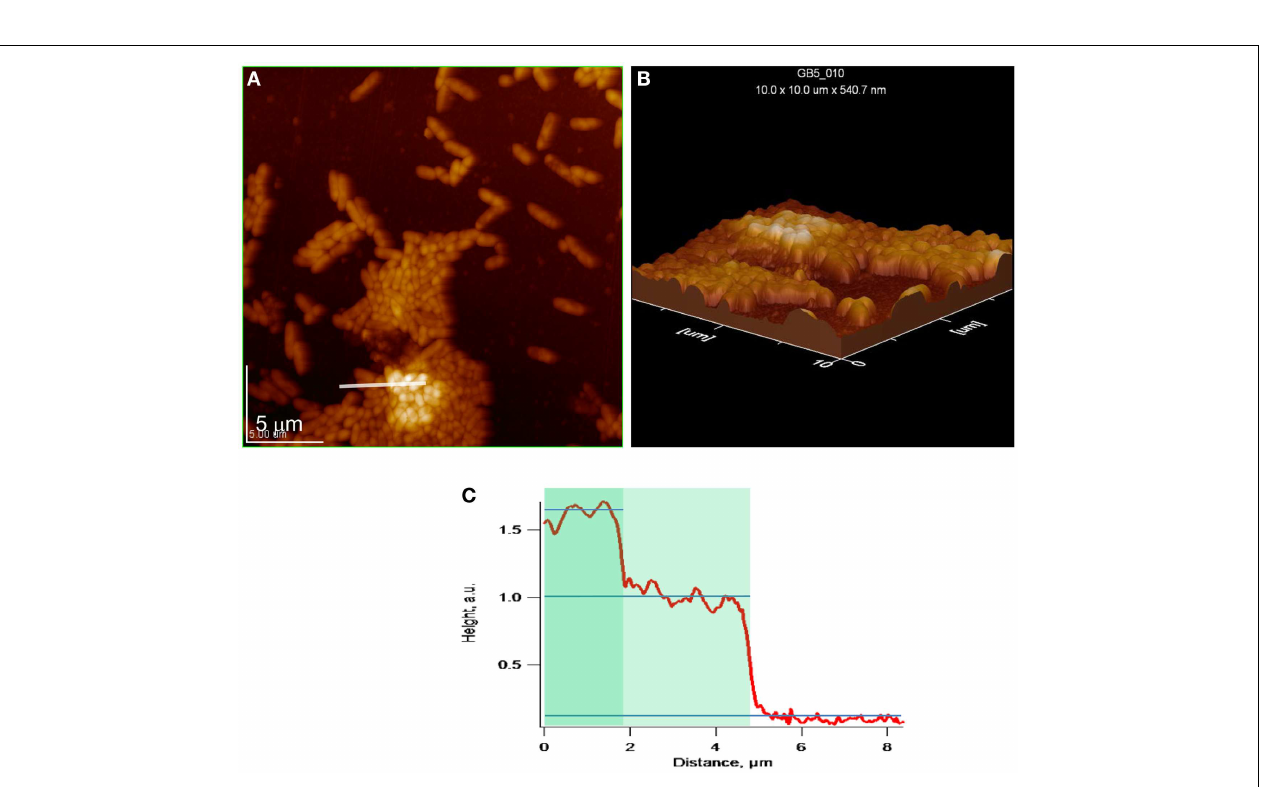
structures observed here by phase AFM indicates that they com- prise nodules that are approximately 20 nm in diameter aligned end to end. If these nodules are redox active (e.g., comprise